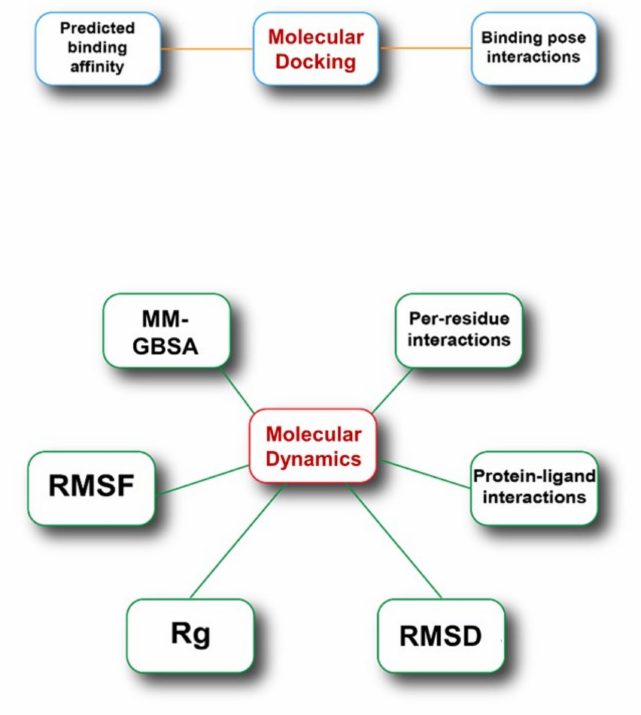
Figure 2. Schematic representation of the parameters analyzed in the process. Molecular redocking experiments were initially performed to assess the reliability of this methodology in predicting the binding mode and, more importantly, the related binding affinity values. Afterward, we performed three independent molecular dynamics simulations (MD1-3) for each system and analyzed the corresponding structural and energetic